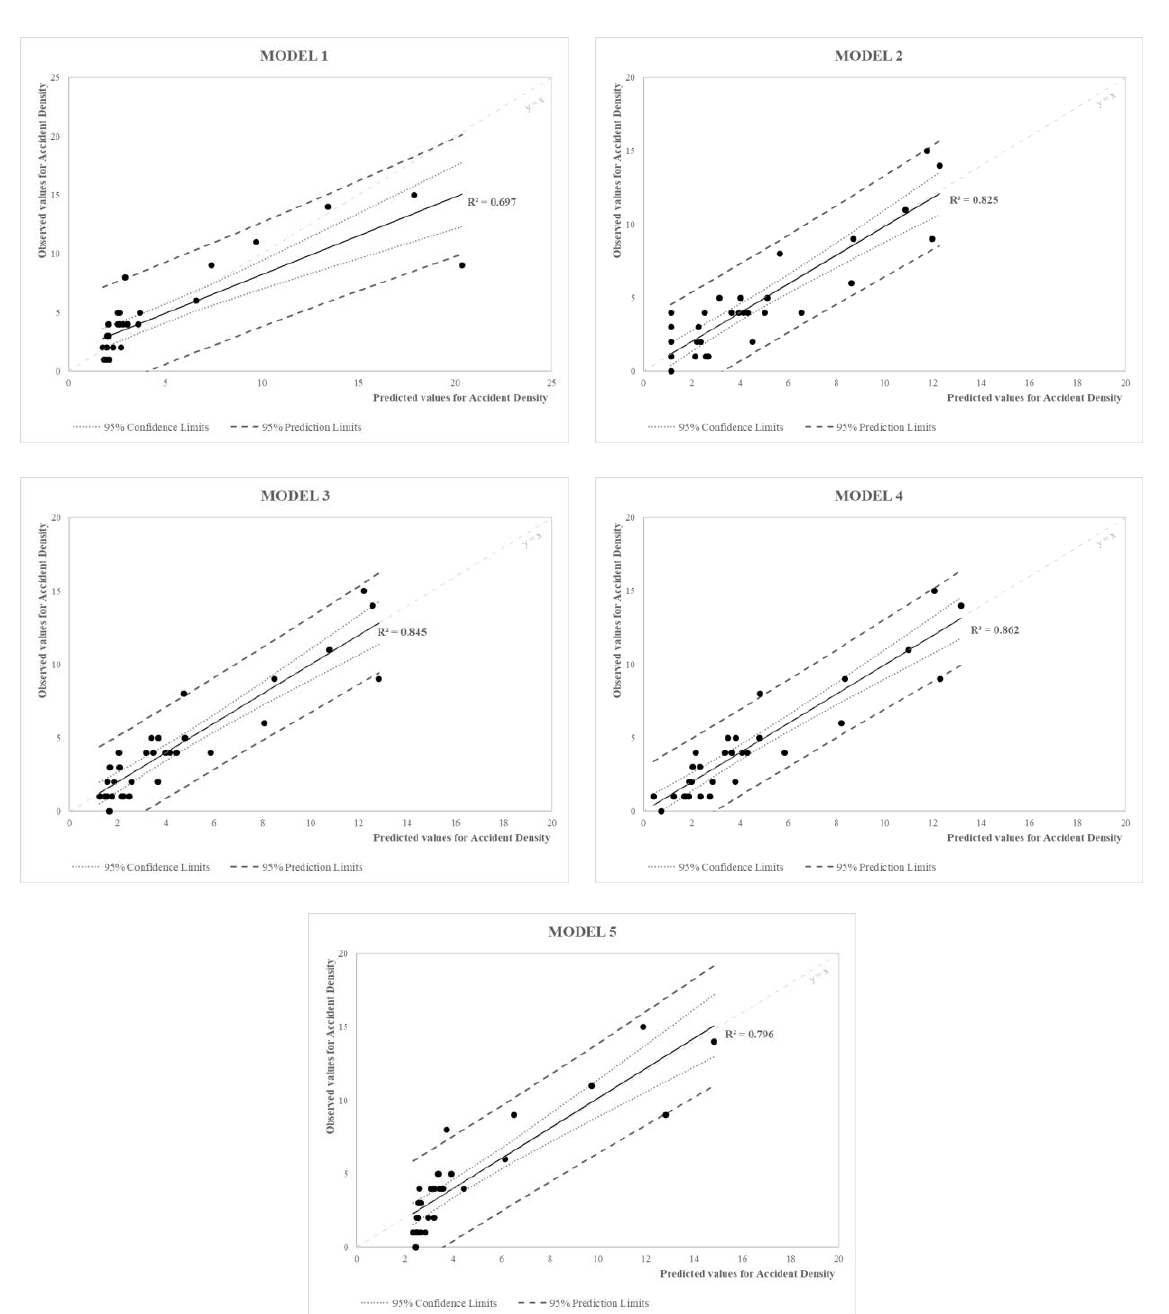
Figure 10. Observed vs. model-estimated values for the five fitted models.